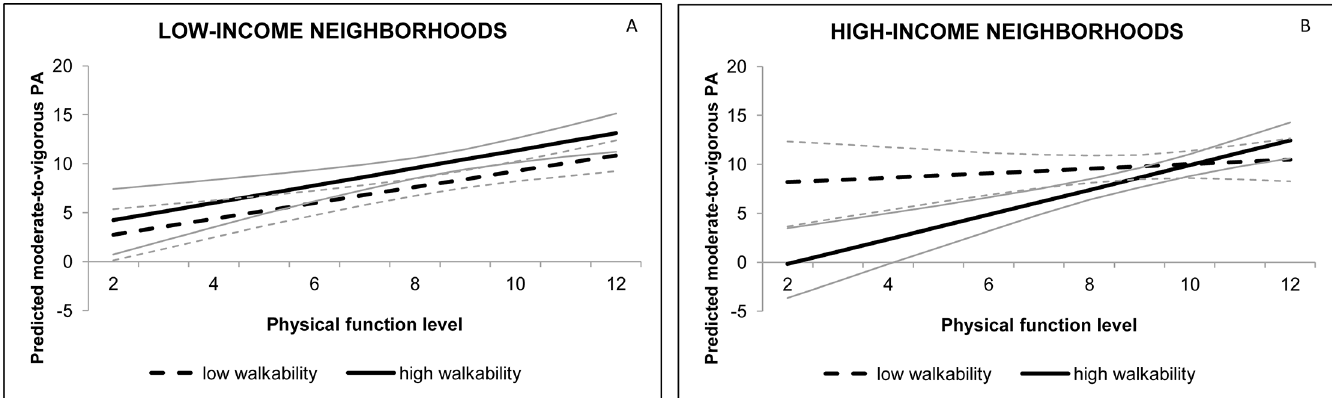
Fig 2. Three-way interaction between physical functioning, neighborhood income, and neighborhood walkability for the predicted MVPA. Fig 2A. shows the moderating effect of neighborhood walkability on the functioning-MVPA association in low-income neighborhoods Fig 2B. shows the moderating effect of neighborhood walkability on the functioning-MVPA association in high-income neighborhoods Plots represent the predicted MVPA of the square root transformed variable for high-walkability (thicker full lines) and low-walkability (thicker dashed lines) neighborhood residents, and their confidence intervals (thinner